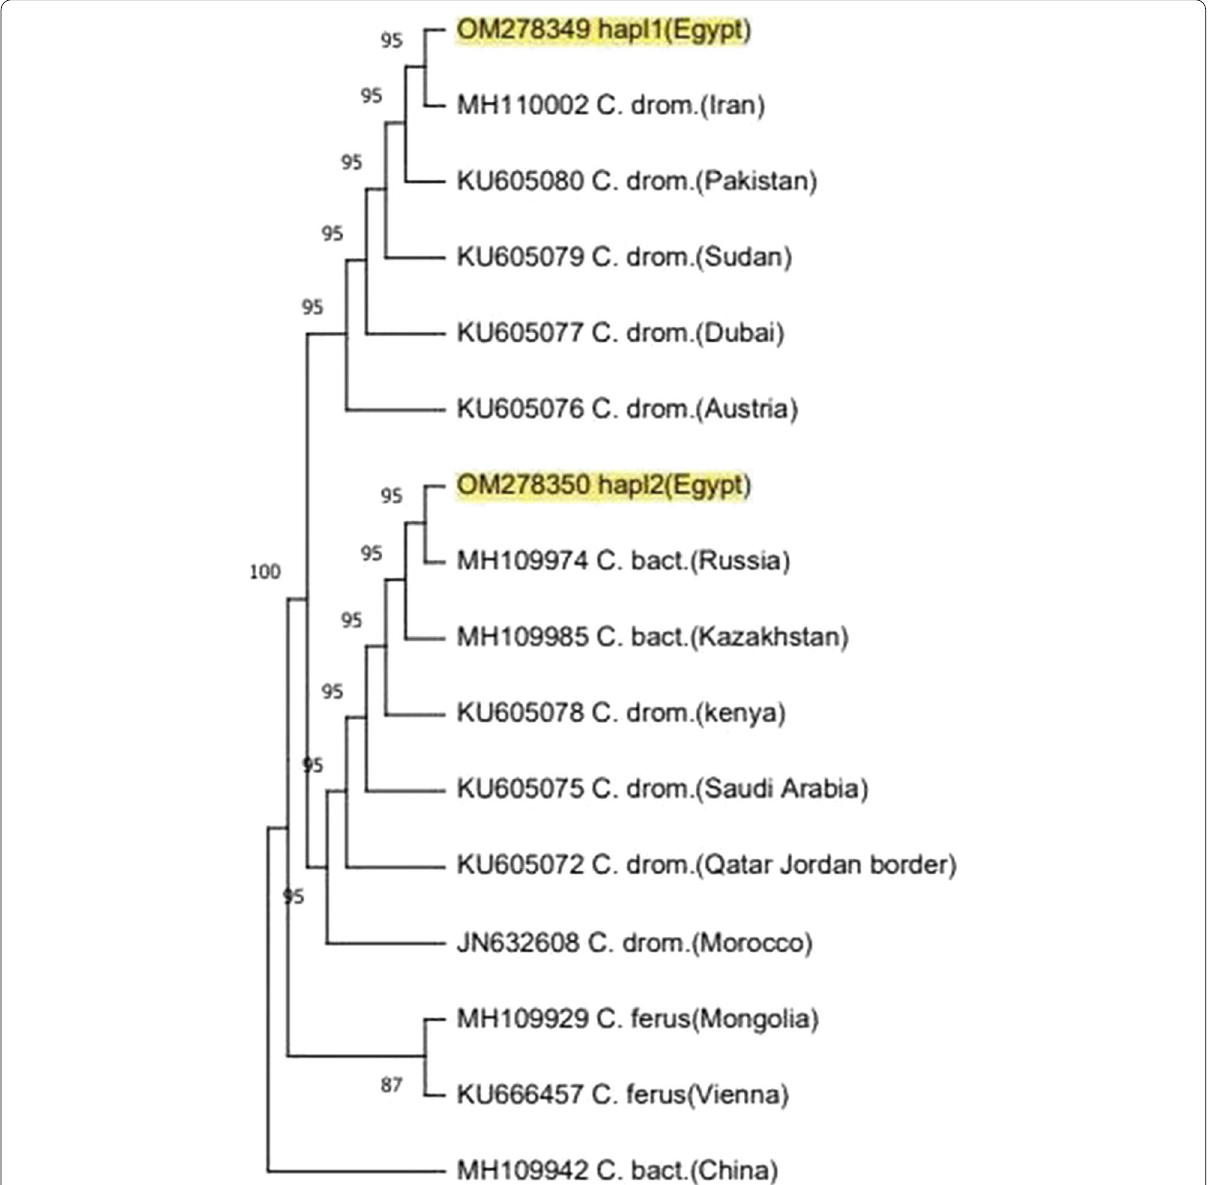
Fig. 6 Phylogenetic tree using the minimum evolution (ME) method among camel populations in Egypt and other published sequences using MEGA 11 computed by Kimura two-parameter model using 1000 bootstrap